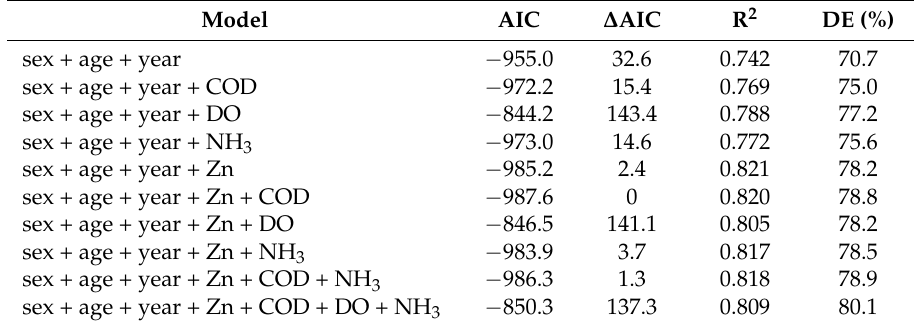
Table 4. The generalized additive models (GAMs) of CKD prevalence in Taiwan using selected river attributes.